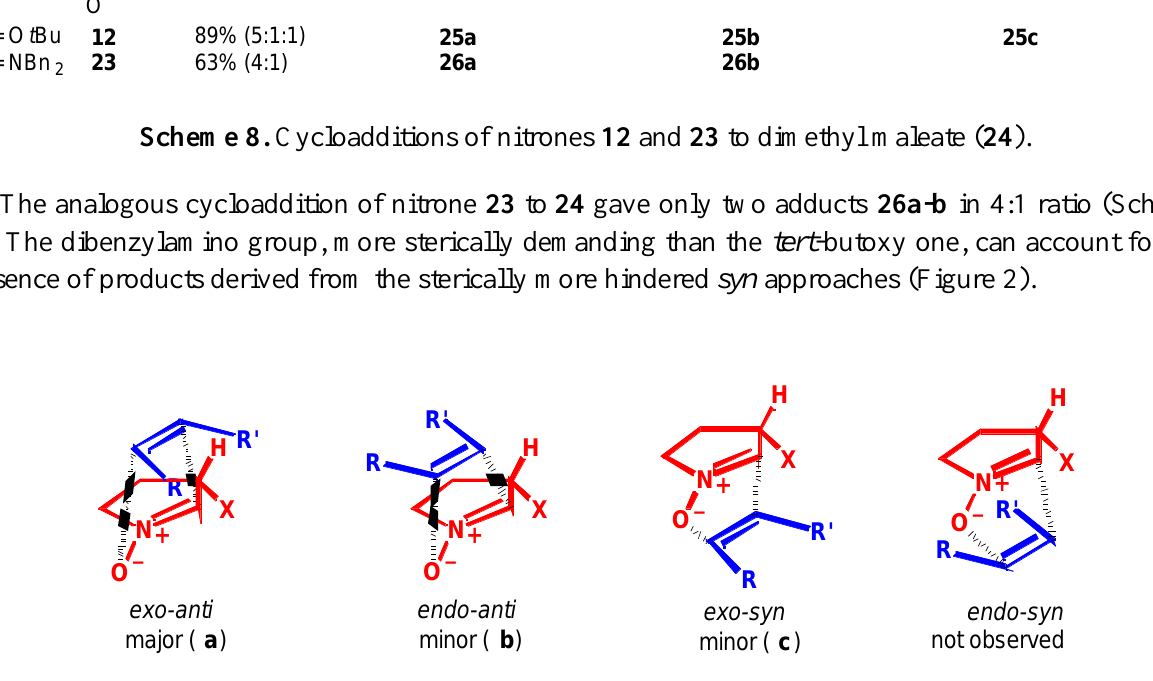
Figure 2. Possible approaches of 3-substituted pyrroline N -oxides to Z -disubstituted ethylenes. g -Crotonolactone ( 27 ) is another suitable dipolarophile for synthesizing the pyrrolizidine